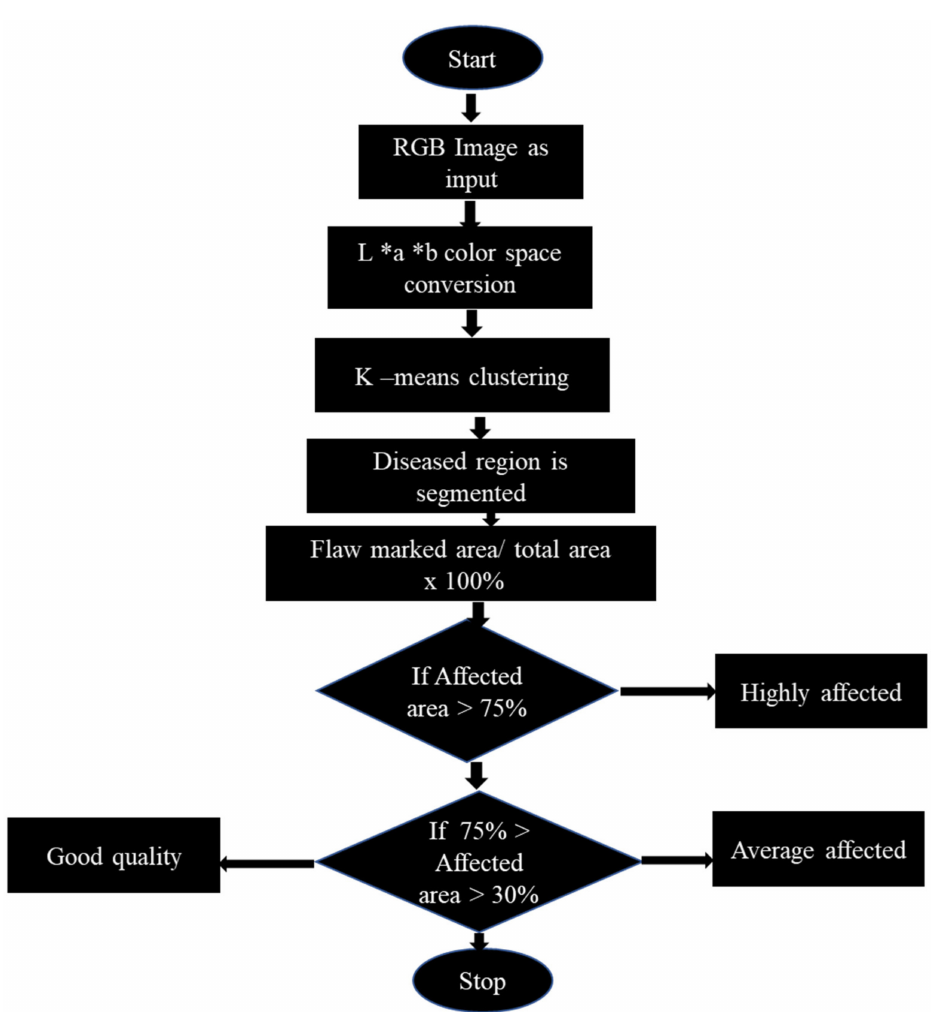
Figure 5. Flow chart of disease detection algorithm using color space conversion